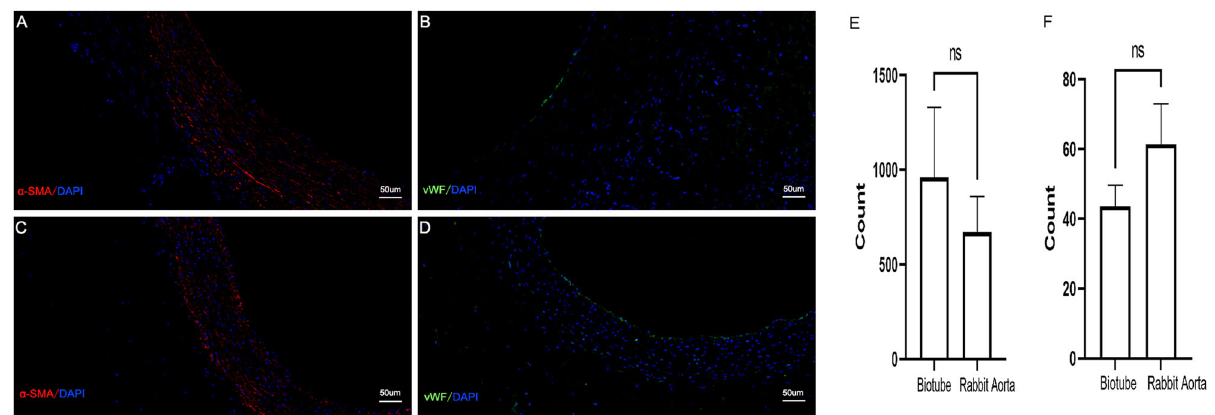
Fig. 12 The Immuno fl uorescence images of biotubes after 12 weeks of implantation ( A , B ) and native rabbit aorta ( C , D ) stained with α -SMA ( A , C positive-Red, DAPI-Blue), vWF ( B , D , positive-Green, DAPI-